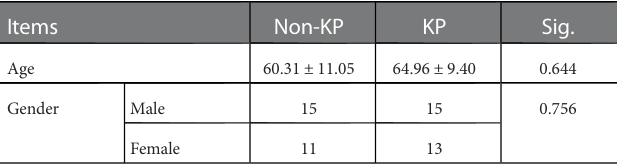
TABLE 1 Basic information of the patients enrolled.